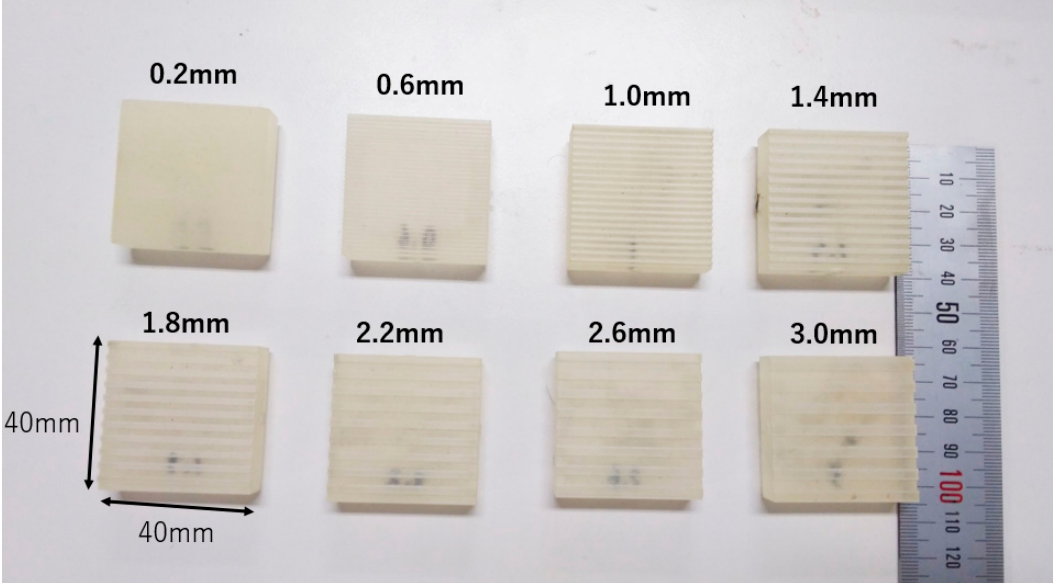
Figure 3. Acrylic texture blocks used as stimuli.